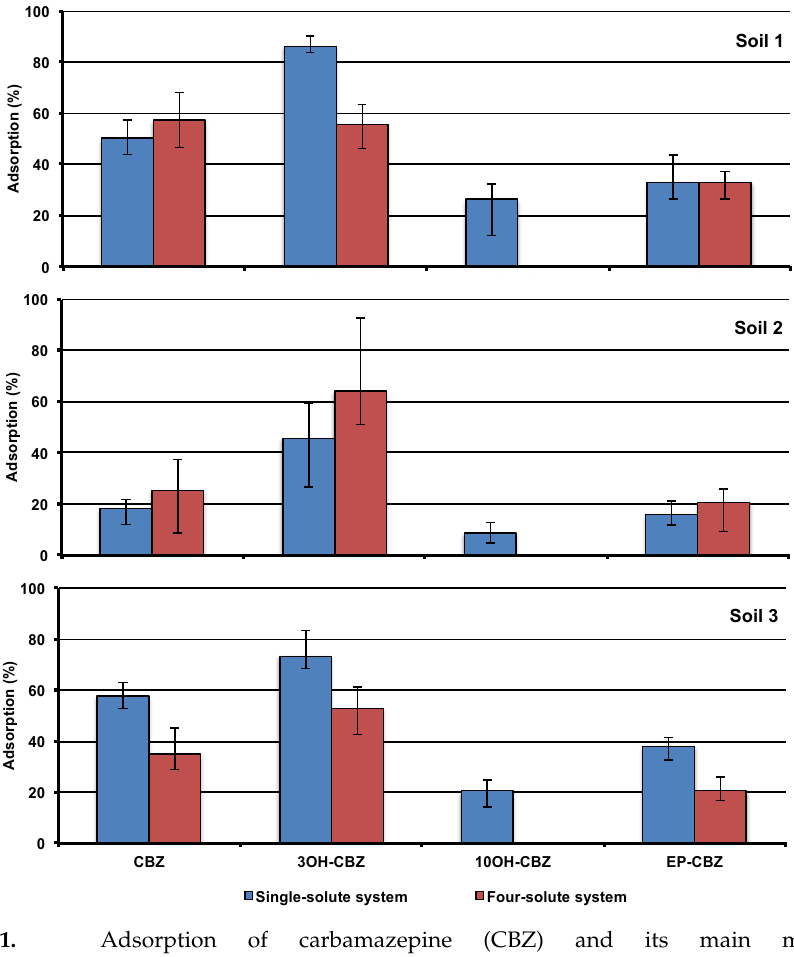
Figure 1. Adsorption of carbamazepine (CBZ) and its main metabolites, 3-hydroxy-carbamazepine (3OH-CBZ), carbamazepine-10,11-dihydro-10,11-epoxide (EP-CBZ), and 10,11-dihydro-10-hydroxycarbamazepine (10OH-CBZ) in the studied soil in single-solute system and in four-solute system.